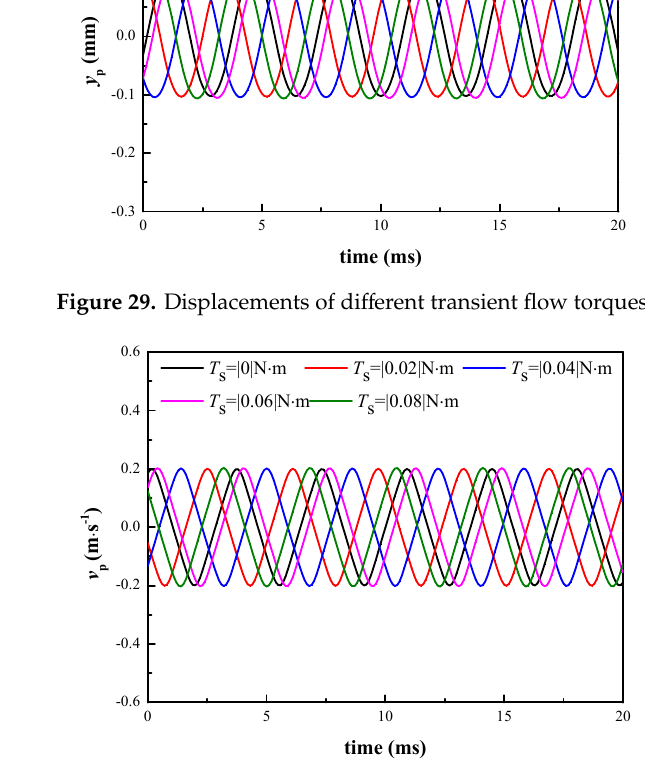
Figure 30. Velocities of different transient flow torques.